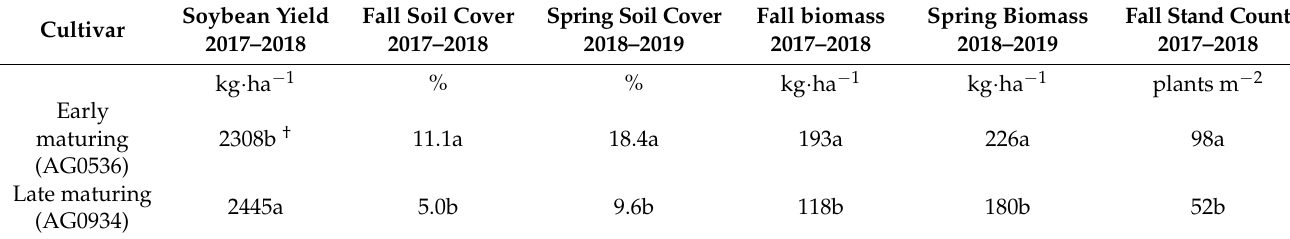
Table 10. Soybean yield, fall and spring cover crop canopy coverage, cover crop biomass, and cover crop stand count readings for two cultivars averaged across five environments in Fargo and Casselton, ND, from 2017, 2018, and 2019. Soybean Cultivar